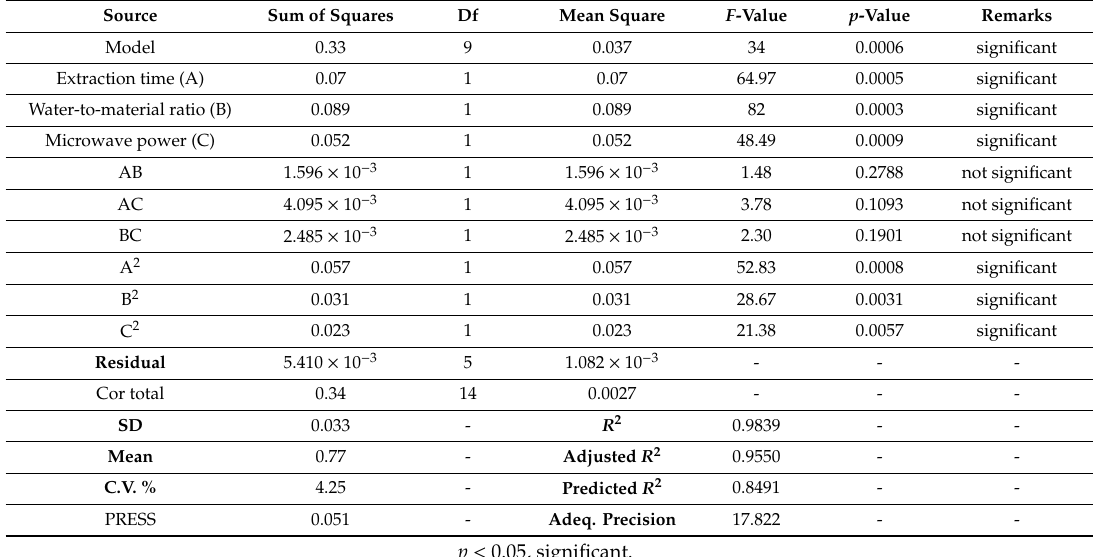
Table 3. ANOVA for the quadratic model.